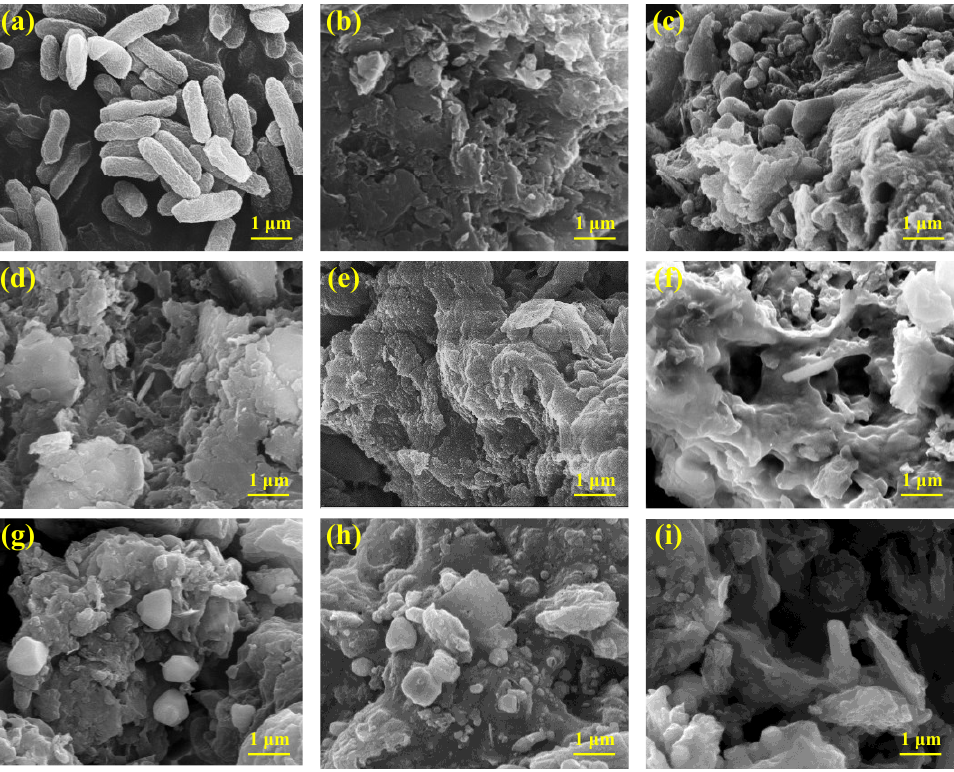
Figure 5. The SEM of ( a ) PA, ( b ) Fe-300, ( c ) Fe-800, ( d ) Fe-300 + PA, ( e ) Cr + Fe-300, ( f ) Cr + Fe-300 + PA, ( g ) Fe-800 + PA, ( h ) Cr + Fe-800 and ( i ) Cr + Fe-800 + PA.